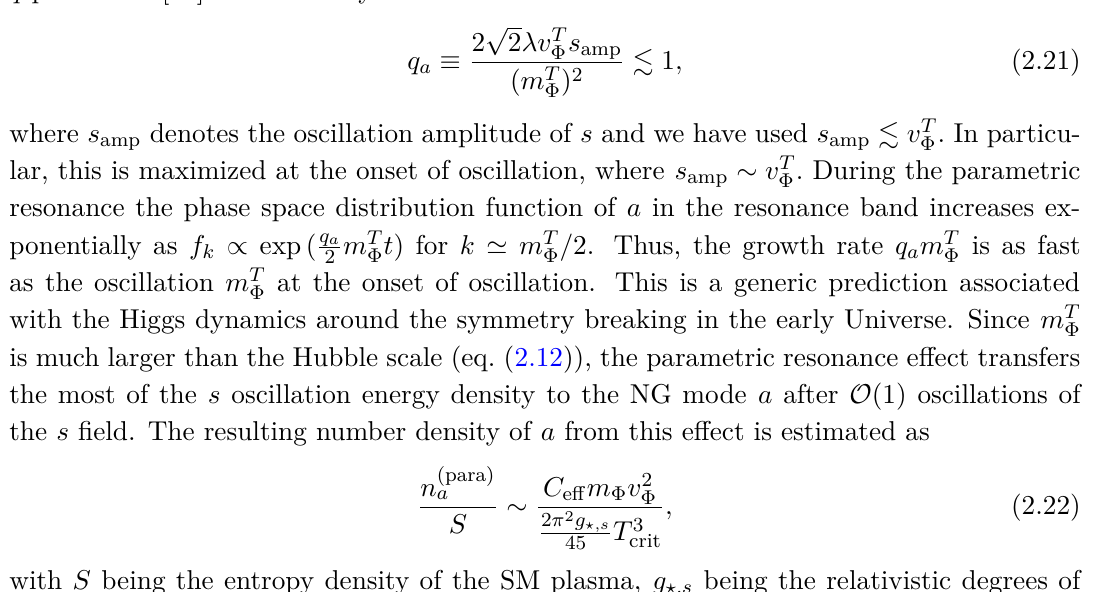
= λ . In the grey shaded P